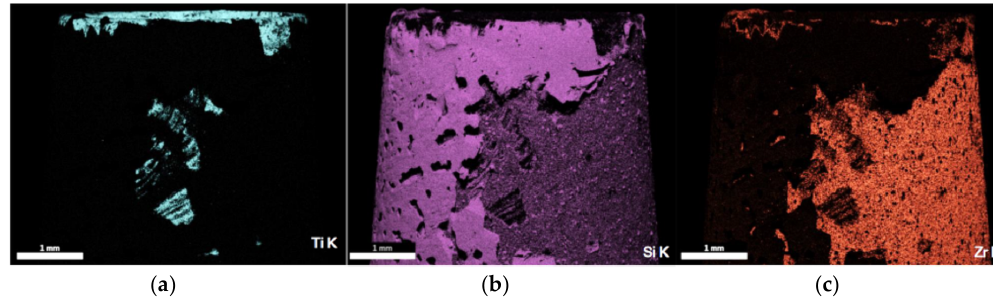
Figure 4. Distribution of the elements titanium ( a ), silicon ( b ), and zirconium ( c ) by energy-dispersive X-ray spectroscopy (EDX)-mapping. Bright areas indicate higher element concentrations.